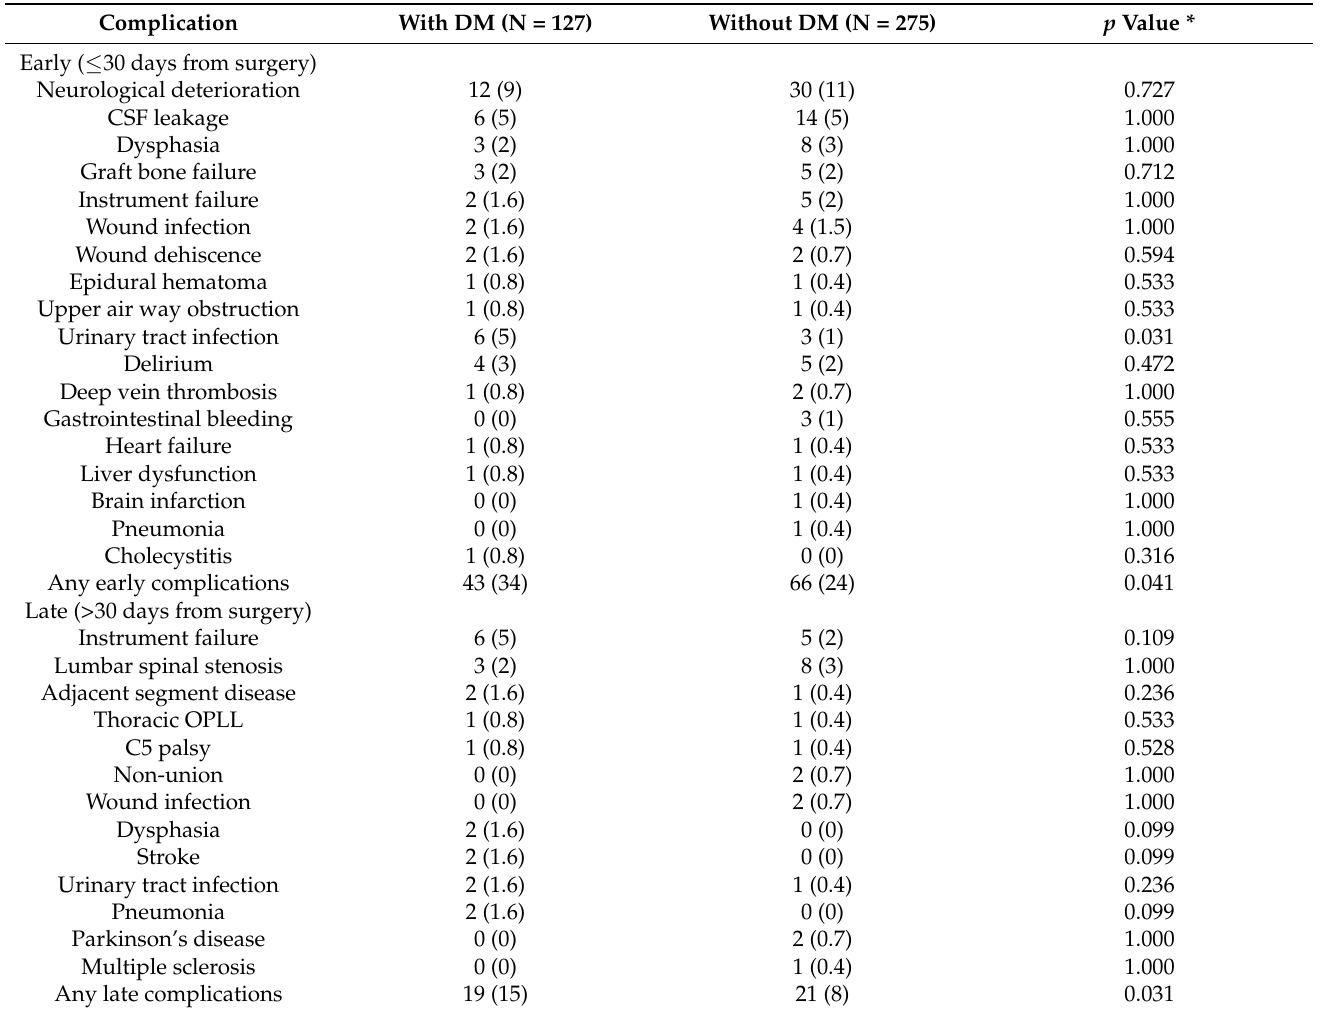
Table 2. Incidence of early and late postoperative complications.